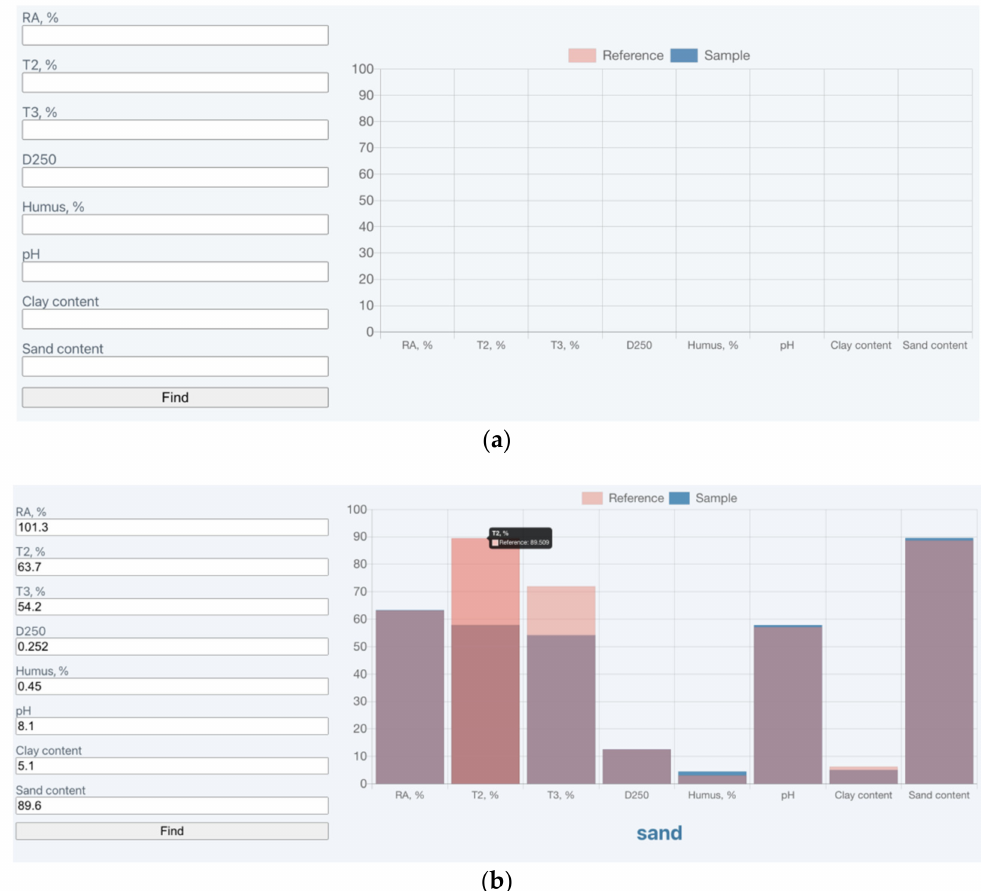
Figure 3. View of the application: ( a ) when launched in a browser; ( b ) when completing the input boxes and selecting a suitable standard soil.